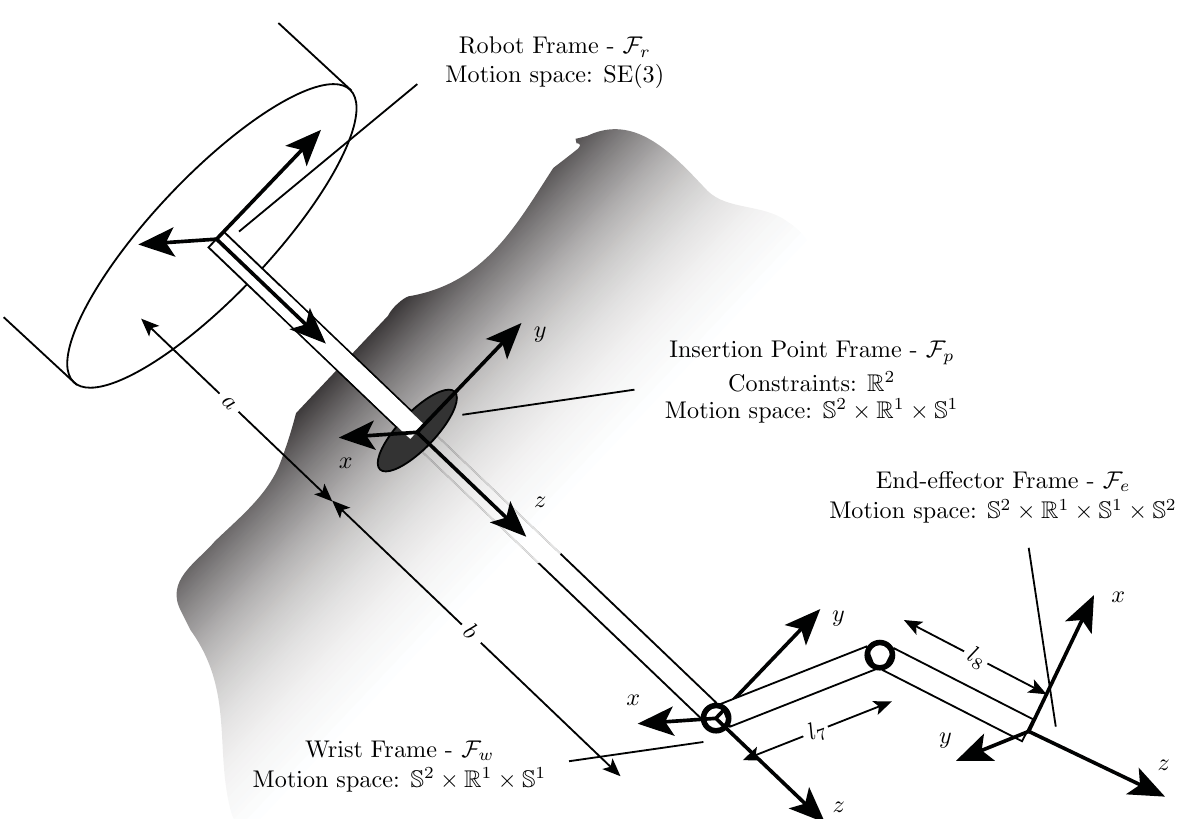
Figure 1: System setup for Robotic-assisted Minimally Invasive Surgery. The configuration spaces at the differ- ent frames are shown in terms of linear motion R and rotational motion S .